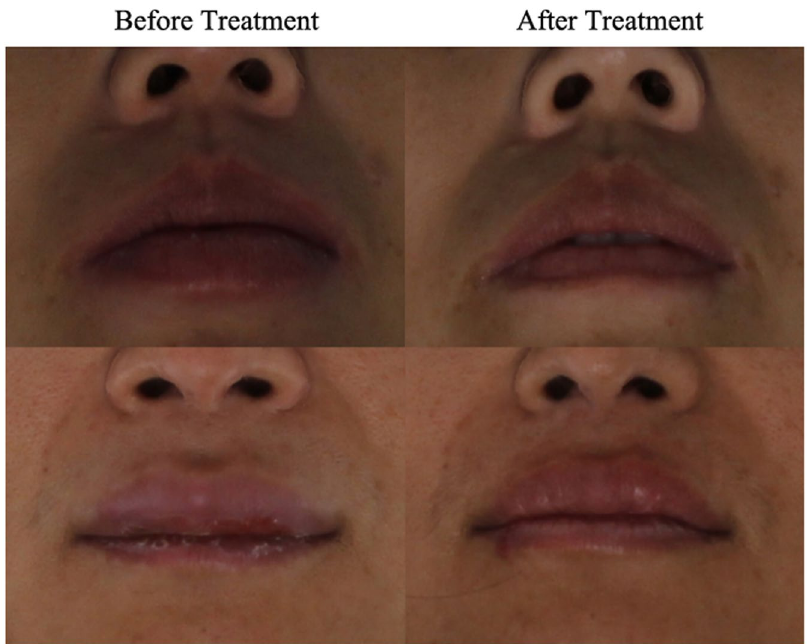
Figure 4. Lip changes before and after treatment.